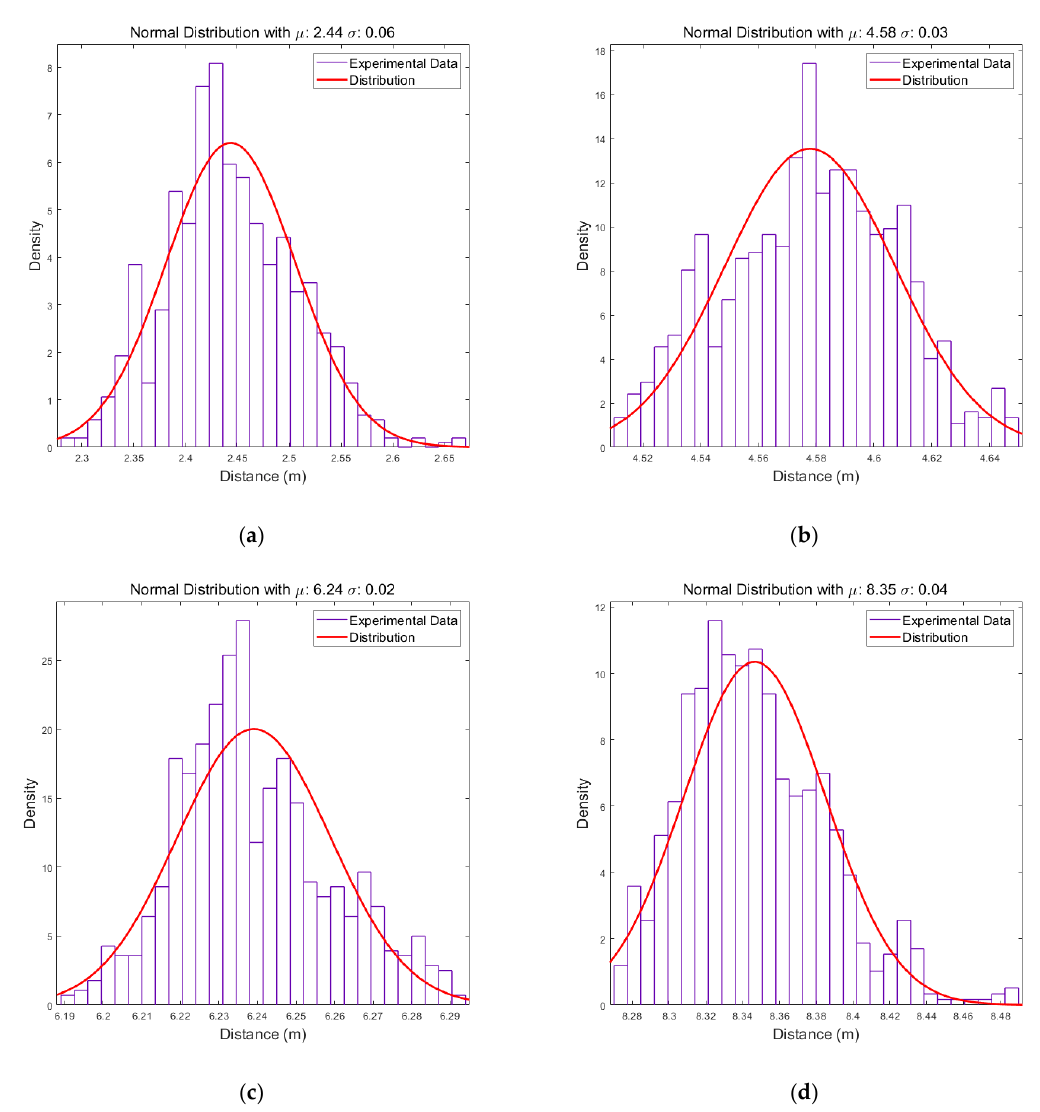
Figure 8. Distribution of distance of the detected target: ( a ) the target is placed approximately 2 m away from the radar; ( b ) the target is placed approximately 4 m away from the radar; ( c ) the target is placed approximately 6 m away from the radar; ( d ) the target is placed approximately 8 m away from the radar.